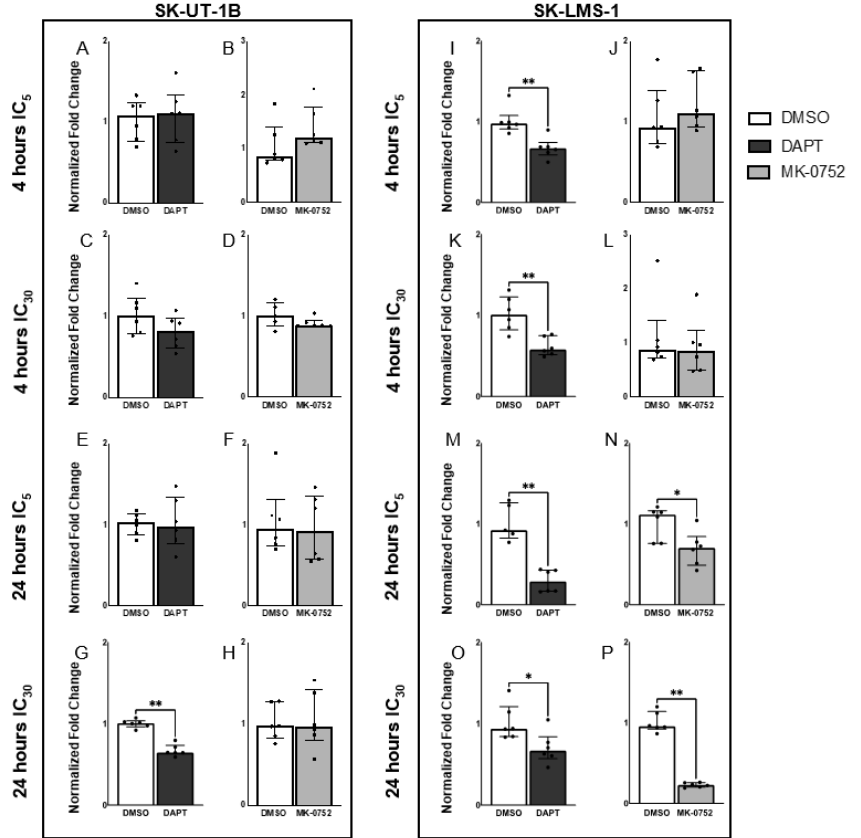
Figure 5. Expression of HES1 in uLMS cells after treatment with DAPT and MK-0752. qRT-PCR determination of HES1 expression after exposure to DAPT, MK-0752, or the DMSO control. The relative expression level of HES1 was compared to 18s rRNA. Expression of HES1 in SK-UT-1B after 4 h of exposure to DAPT at IC 5 of 15 µ M ( A ), DAPT at IC 30 of 50 µ M ( C ), MK-0752 at IC 5 of 50 µ M ( B ) or MK-0752 at IC 30 of 95 µ M ( D ) was similar to the DMSO controls. Expression of HES1 in SK-UT-1B after 24 h of exposure to DAPT at IC 5 of 15 µ M ( E ), MK-0752 at the IC 5 of 50 µ M ( F ) or MK-0752 at the IC 30 of 95 µ M ( H ) was similar to the DMSO controls. HES1 expression was significantly decreased in SK-UT-1B after 24 h with DAPT at the highest concentration, IC 30 of 50 µ M (( G ), FC: 1.55, p ≤ 0.01). Expression of HES1 was significantly decreased in SK-LMS-1 after 4 h with DAPT at IC 5 of 20 µ M (( I ), FC:1.46, p ≤ 0.01) and IC 30 of 60 µ M (( K ), FC:1.74, p ≤ 0.01). Expression of HES1 in SK-LMS-1 after 4 h of exposure to MK-0752 at the IC 5 of 50 µ M ( J ) or MK-0752 at the IC 30 of 100 µ M ( L ) was similar to the DMSO controls. Expression of HES1 in SK-LMS-1 was significantly decreased after 24 h of exposure to DAPT at IC 5 of 20 µ M (( M ), FC: 3.17, p ≤ 0.01) and DAPT at IC 30 of 60 µ M (( O ), FC: 1.40, p ≤ 0.05) and 24 h of exposure to MK-0752 at IC 5 of 50 µ M (( N ), FC: 1.60, p ≤ 0.05) and MK-0752 at IC 30 of 100 µ M (( P ), FC:4.17, p ≤ 0.01). Data are presented as median + IQR with n = 6 for each treatment and * p ≤ 0.05, ** p ≤